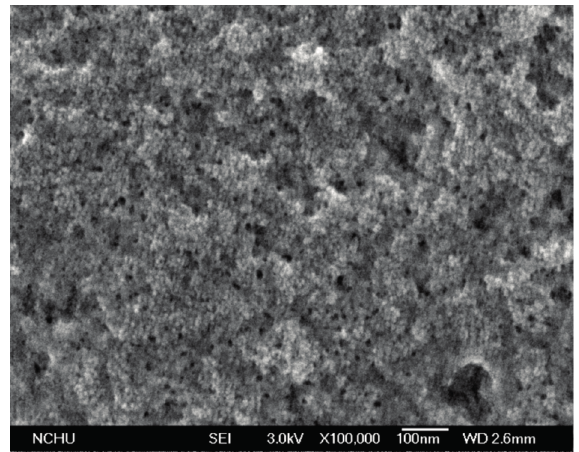
Figure 4. SEM image of the tin dioxide